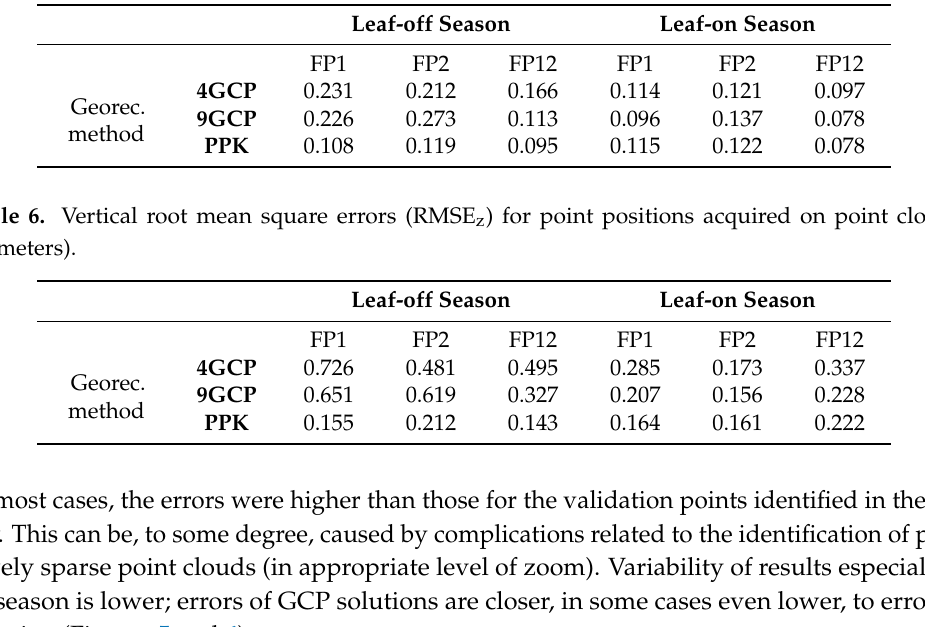
Table 5. Horizontal root mean square errors (RMSE xy ) for point positions in the point clouds (in meters).